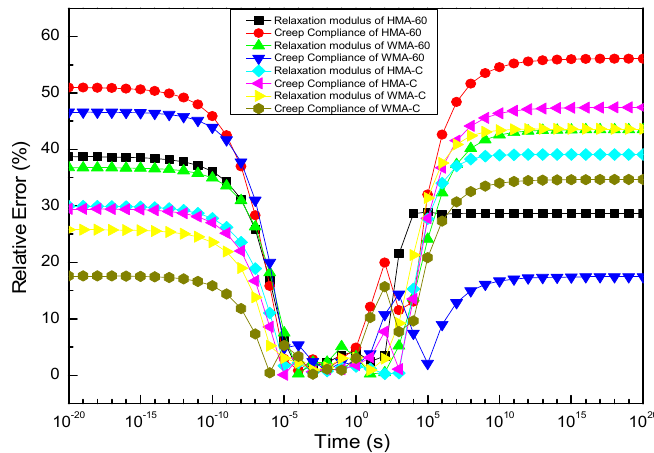
Figure 13. Relative errors of the relaxation modulus and creep compliance produced by methods of the discrete and continuous